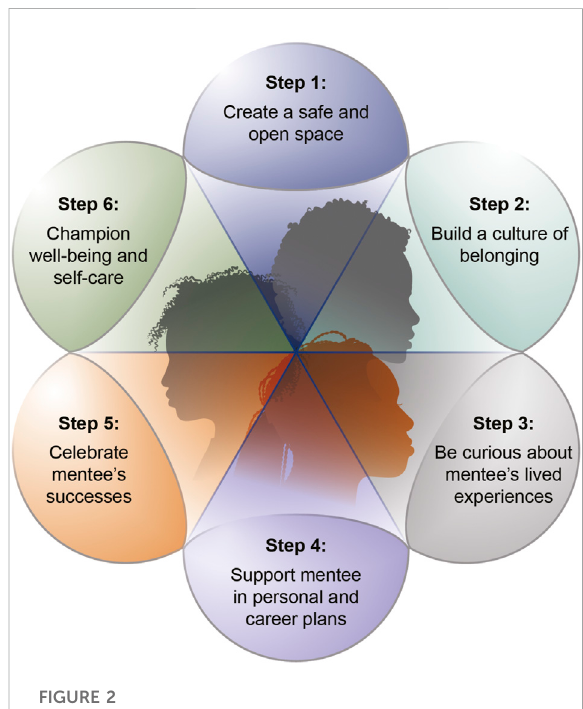
FIGURE 2 Six steps of intentional mentoring to enhance diversity and inclusion in neuro-psychiatric and behavioral